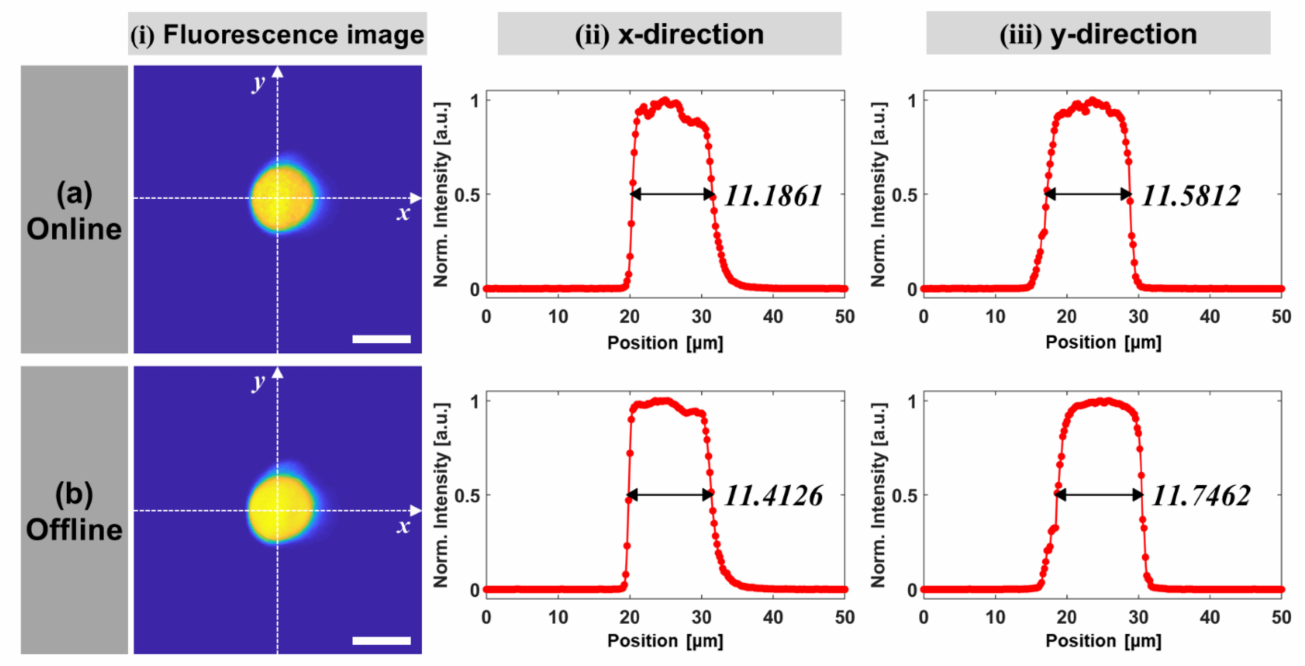
Figure 8. Quantitative comparison of the performance of ( a ) online and ( b ) offline systems. ( i ) Fluorescent microsphere images, and the corresponding diameter of the ( ii ) x-direction and ( iii ) y-direction intensity profiles (scale bar: 10 µ